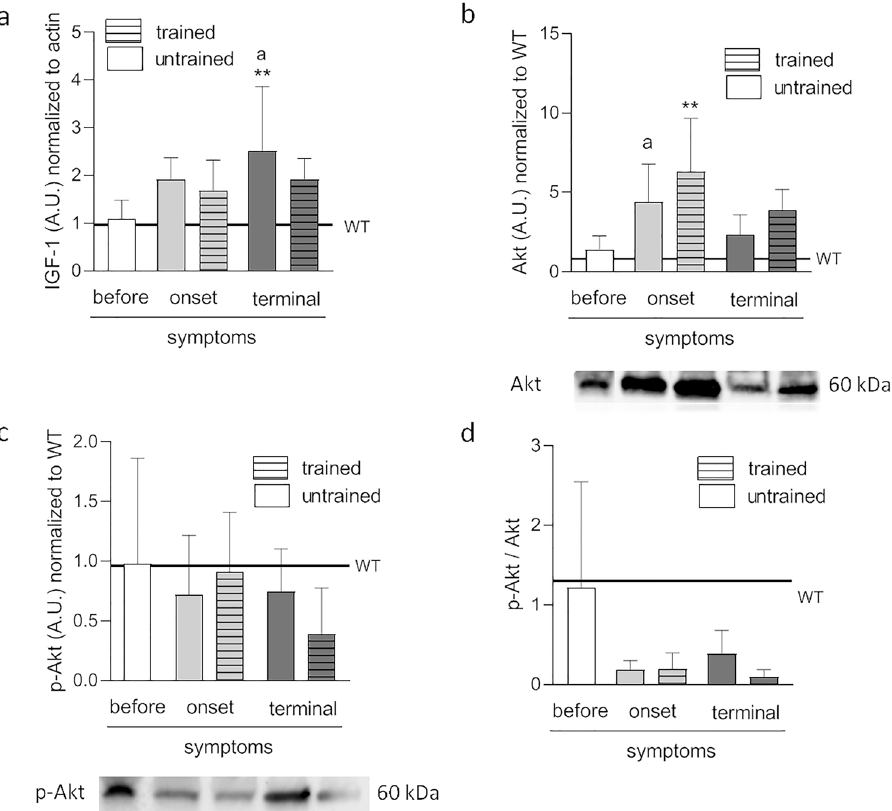
Figure 1. Effects of ALS disease progression and swim training on IGF-1 and Akt signaling pathway. IGF-1 (a) , Akt (b) , p-Akt (c) , and p-Akt to Akt ratio (d) were measured in tibialis anterior muscle. There were significant differences between the groups: **p < 0.01 vs. WT group of mice, a p < 0.05 vs. BEFORE group, The data are presented as the means ± SEM (n = 5 in each group). Full-length blots are displayed in Supplementary Fig. S6 and Fig.